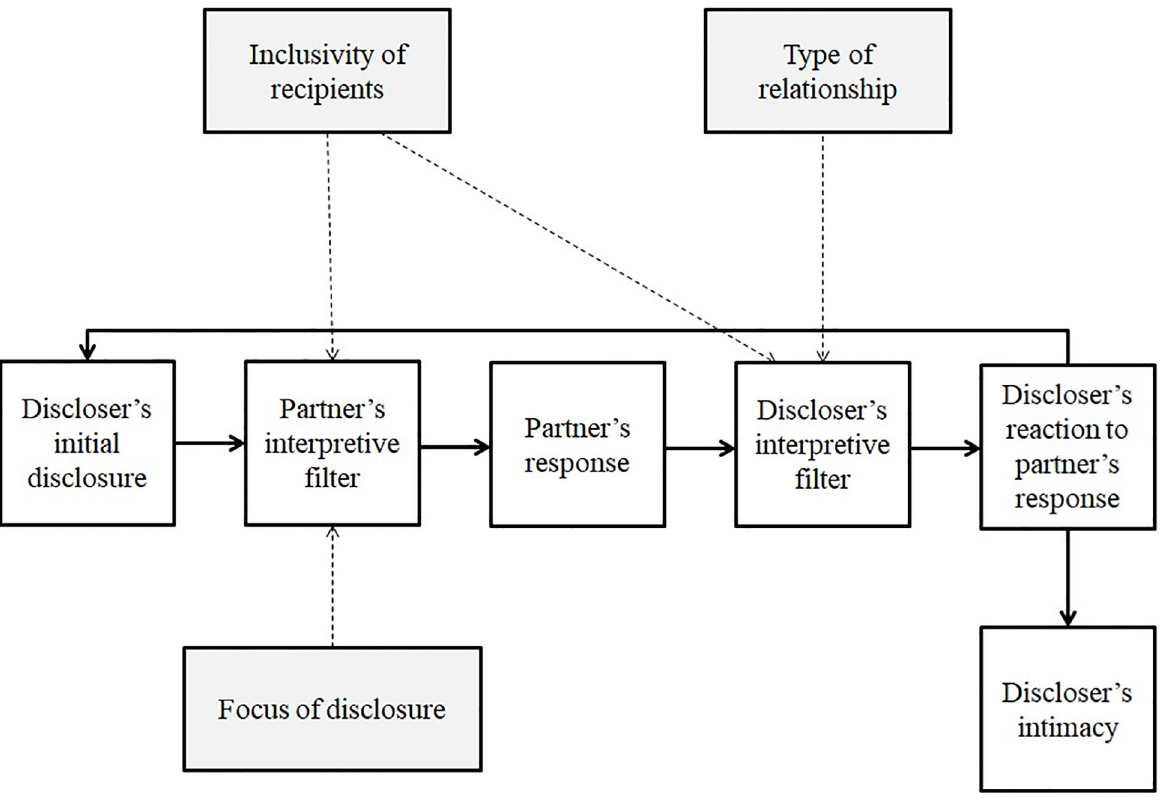
Fig 5. Extended interpersonal process